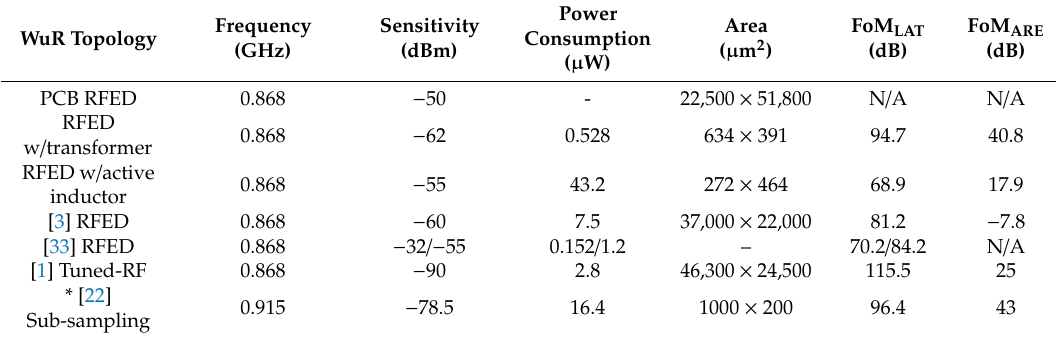
Table 3. Performance summary of the explored RFED-based